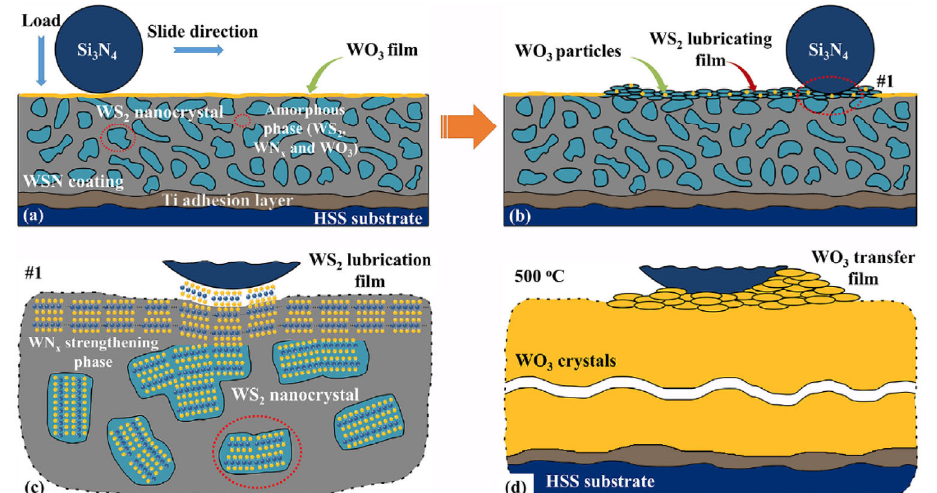
Fig. 48 Schematic of lubrication mechanism. (a, b) Lubrication system; (c) partial enlarged view of friction pair contact area #1; (d) formation for WO 3 transfer film at 500 °C [824]. Reproduced with permission from Ref. [824], © Elsevier B.V.,